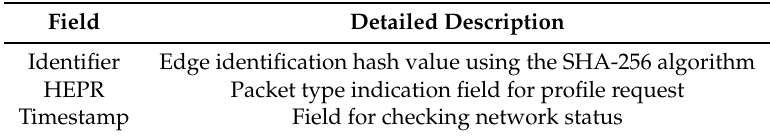
Figure 2. Hierarchy Edge Profile Request (HEPR) message format and example. Table 1. Hierarchy Edge Profile Request (HERP) message fields and